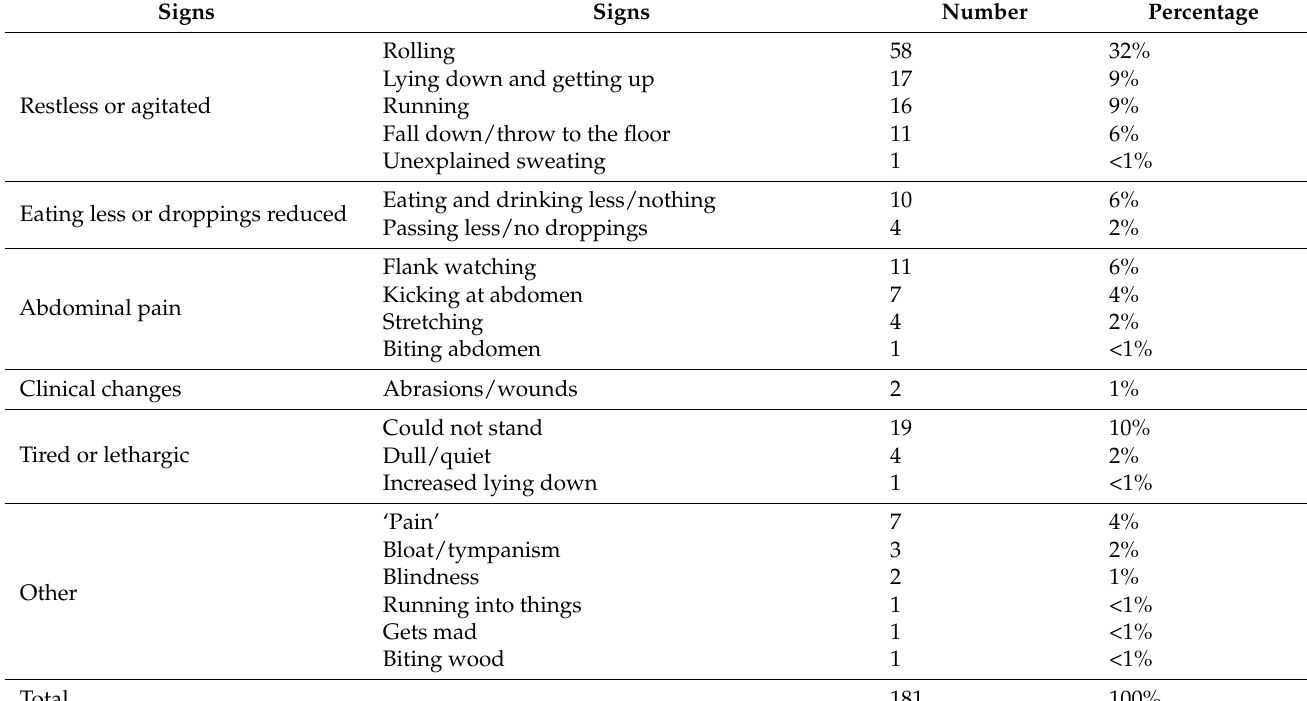
Table 2. Clinical signs of colic listed by 65 owners in Choluteca, Honduras during verbal questionnaires and grouped according to the ‘REACT’ acronym [27] (Supplementary Items, Figure S1). Number indicates the total number of owners that gave this response, which were totaled, with a percentage given to each symptom. A total of 181 clinical signs were given, i.e., some owners mentioned more than one clinical